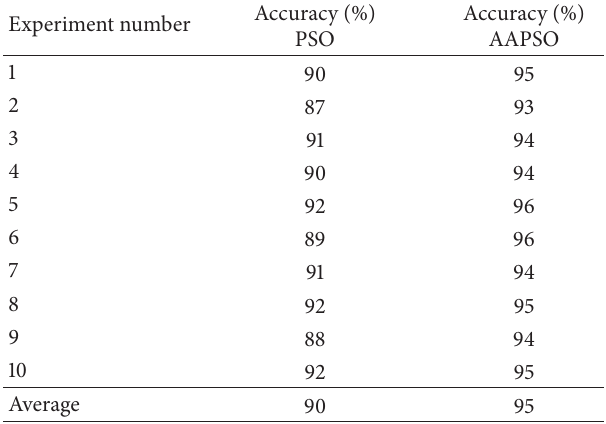
Table 1: The accuracy of PSO and AAPSO based on SVM classifica- tion performance results for the UBiris